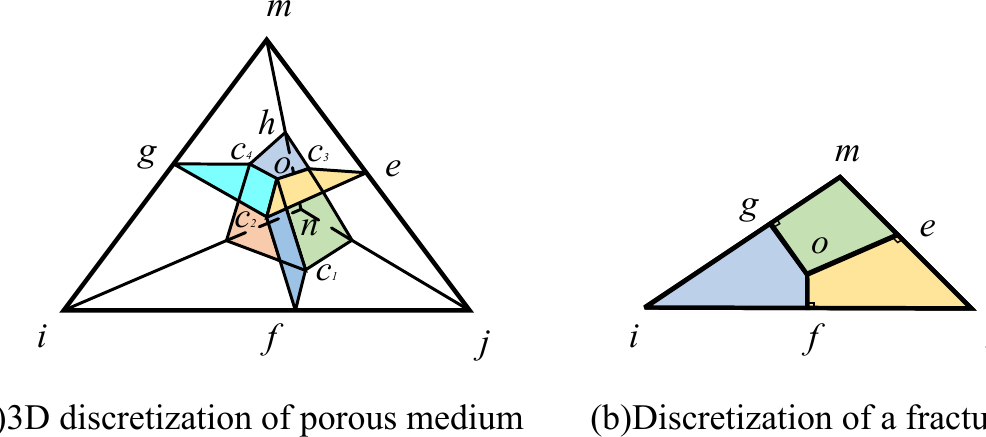
Figure 1. Discrete elements within fractured and porous